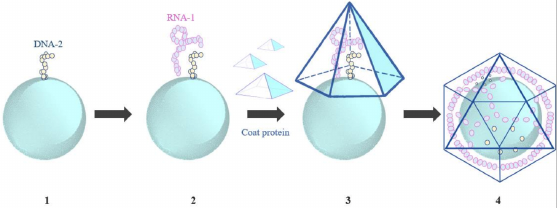
Figure 4. Mechanism of reassembly of RCNMV coat protein around metal nanoparticles [163]. ( 1 ) metal nanoparticles were linked with synthetic oligonucleotides (DNA-2) mimicking the OAS, ( 2 ) RCNMV RNA-1 was used to interact with DNA-2, ( 3 ) OAS formation, ( 4 ) reassembly of RCNMV coat proteins